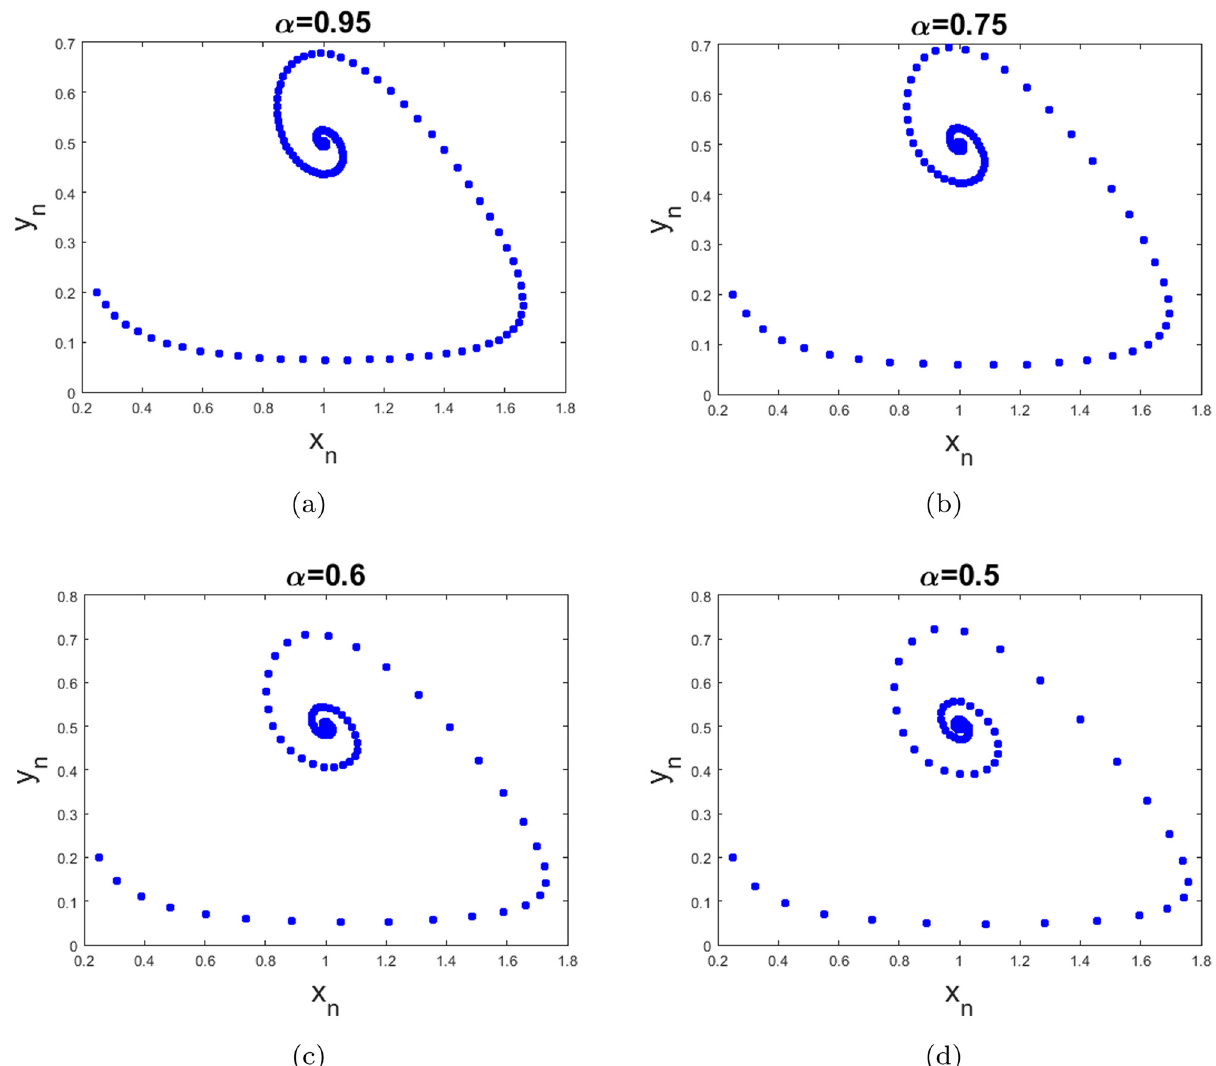
Figure 1: Stable dynamical behavior of system ( 8 ) subject to the initial condition ( ( ) ( )) ( ) = x y 0 , 0 0.25, 0.2 for the parameters = = = p q h 0.5, 1, 0.15, and = r 1 : ( a ) = α 0.95 , ( b ) = α 0.75 , ( c ) = α 0.6 , and ( d ) = α 0.5